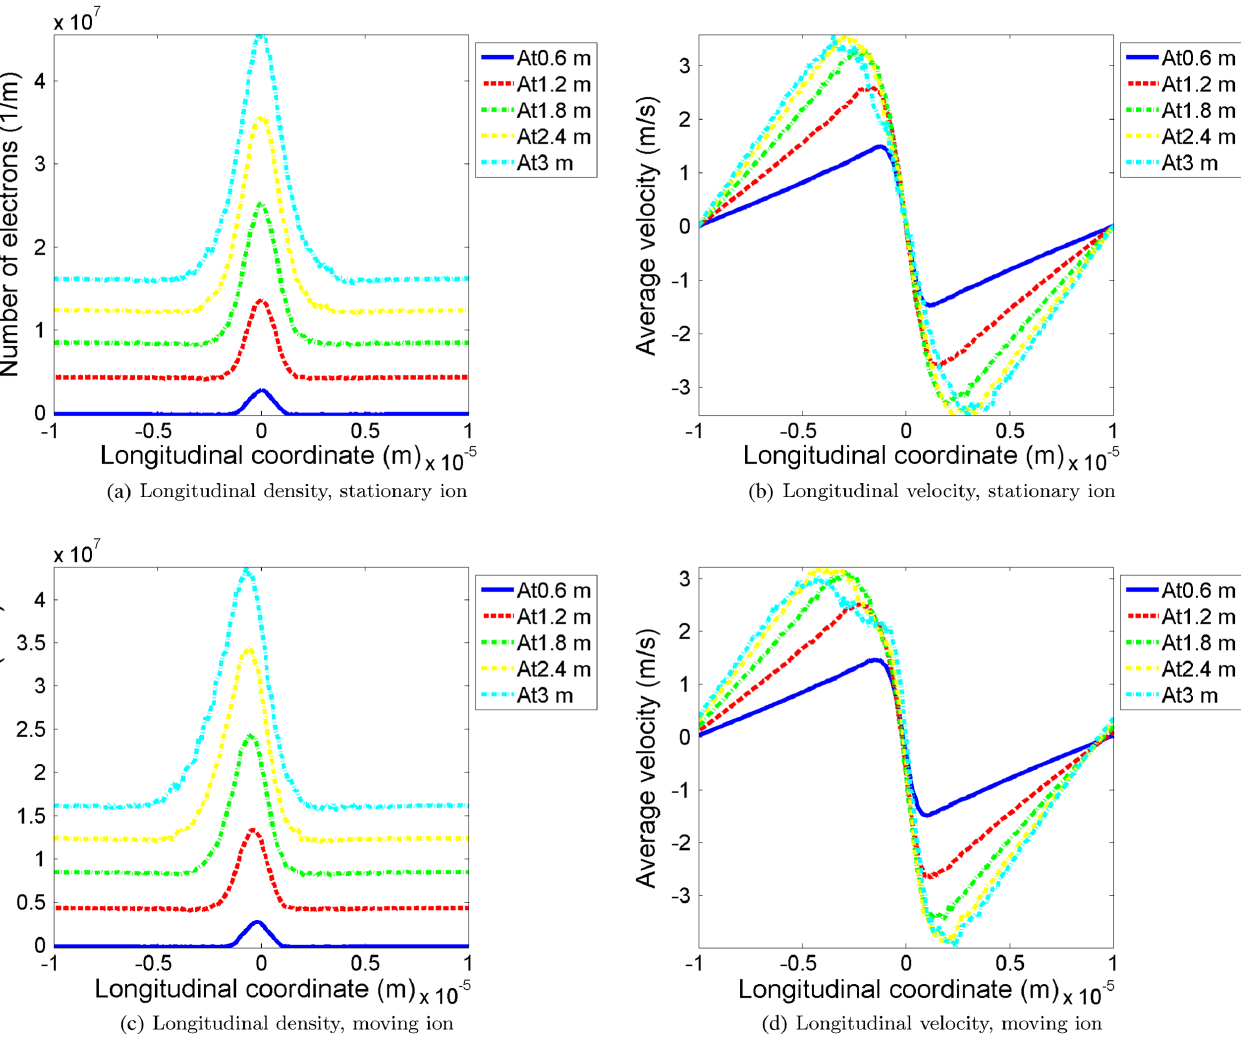
FIG. 9. Longitudinal density and velocity modulation by stationary and moving ions, transversely located in the center of the Gaussian electron beam after 0.6 m (blue, solid line), 1.2 m (red, dash line), 1.8 m (green, dash-dot line), 2.4 m (yellow, dash-dot line), and 3 m (cyan, dash-dot line) length of copropagation.